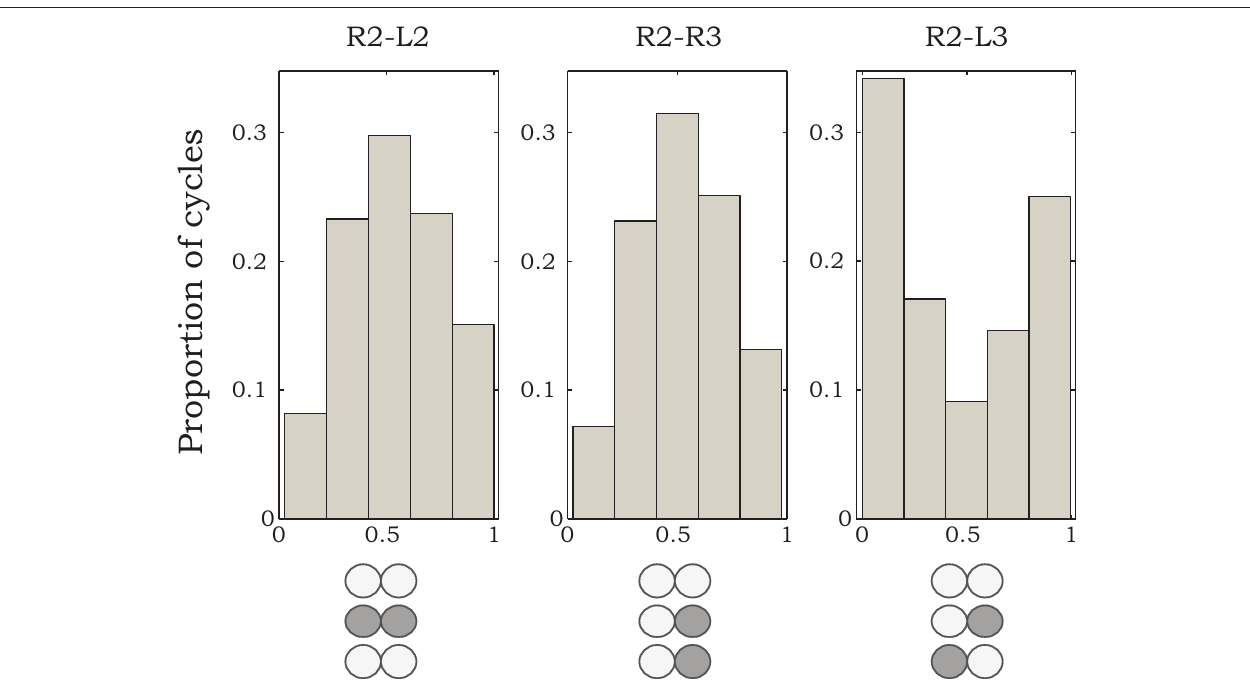
Figure 2 | Histograms of phase differences in burst activity recorded from coxal MNs of r2–L2, r2–r3, and r2–L3. We analyzed data from nine animals, from which we could record burst activity from R2–L2 and R2–R3 in five preparations, and from R2–L3 in four preparations. Sequences of 50 burst cycles were taken for each preparation. Histogram areas are normalized to 1.